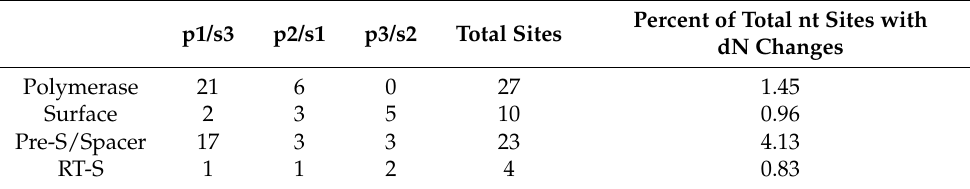
Table 2. Nonsynonymous substitutions by codon position of the overlapping Polymerase (P) and Surface (S) genes, restricted to the spacer region of P and pre-S region of S. Percent of Total nt Sites with p1/s3 p2/s1 p3/s2 Total Sites dN Changes Polymerase 21 6